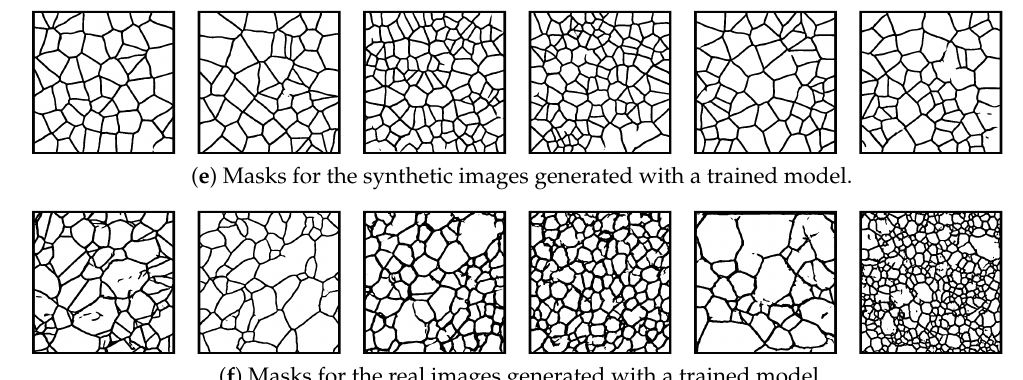
Figure 4. ( a – f ) Grain boundary segmentation. Images in ( b ) from left to right were taken with permission from [45,46], courtesy of Prof. D. Rafaja, TU Bergakademie Freiberg (2 images),